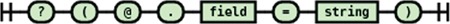
JSONPath expression syntax recognized.